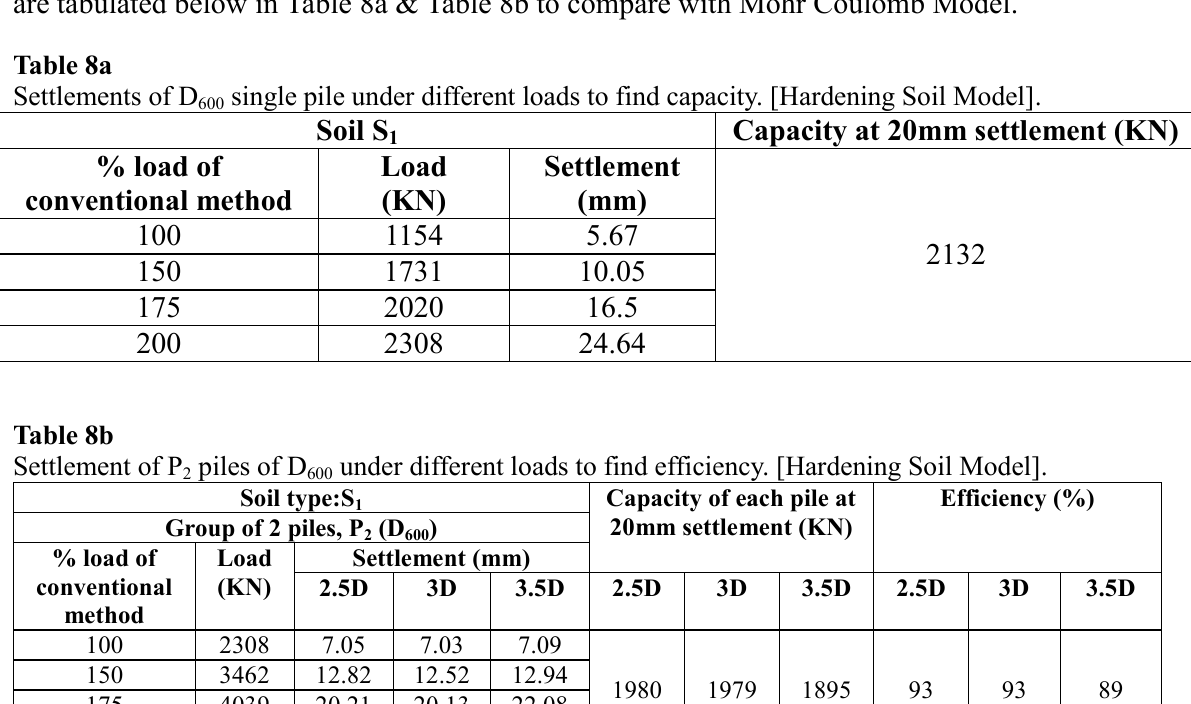
Settlement of group of two piles of D